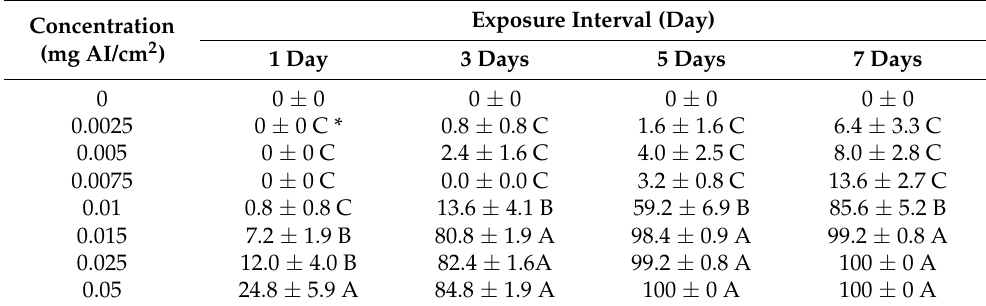
Table 3. Mean corrected mortality (% ± SE) of Acanthoscelides obtectus adults after 1-, 3-, 5- and 7-day exposure to laminate flooring surface treated with spinetoram at eight different